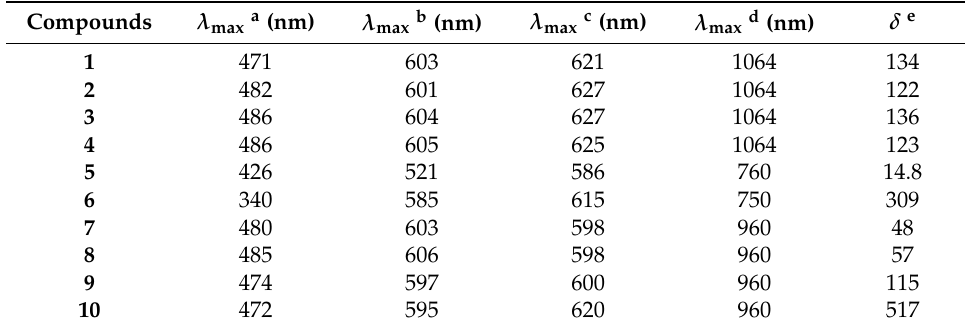
Figure 3. Molecular structures of 1 – 10 . Table 1. Photophysical data of 1 – 10 .